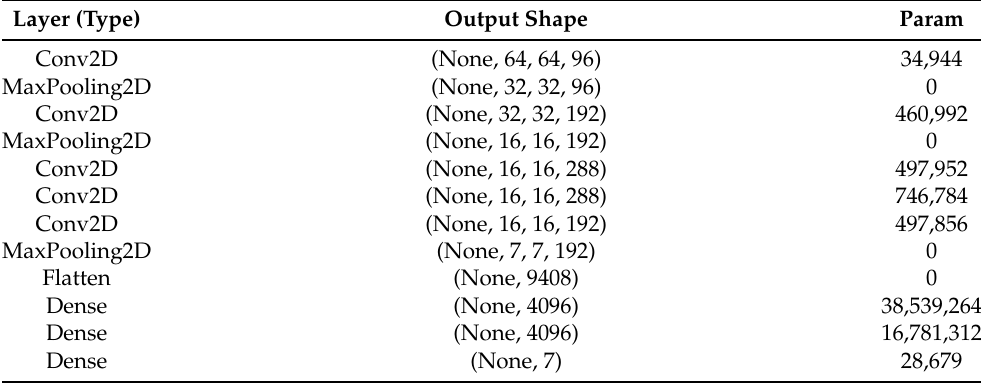
Table 3. AlexNet parameter